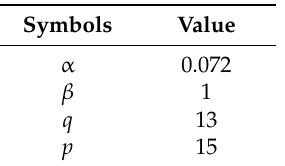
Table 1. Parameters of